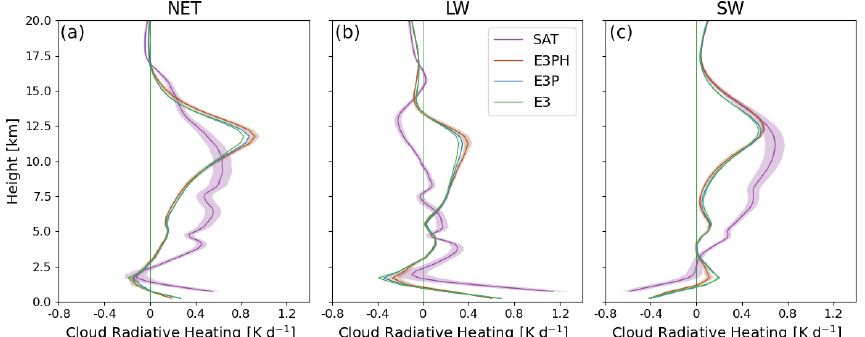
Figure 6. Vertical cloud radiative heating for EC-Earth3P-HR (E3PH), EC-Earth3P (E3P), EC-Earth3 (E3) and CloudSat/CALIPSO ob- servations (SAT) averaged over the entire tropics for each height bin. (a) Net (SW + LW; NET) heating, (b) longwave (LW) heating and (c) shortwave (SW) heating, for all seasons. Shaded areas show ± 1 σ spread for CloudSat/CALIPSO and EC-Earth3P-HR based on monthly mean